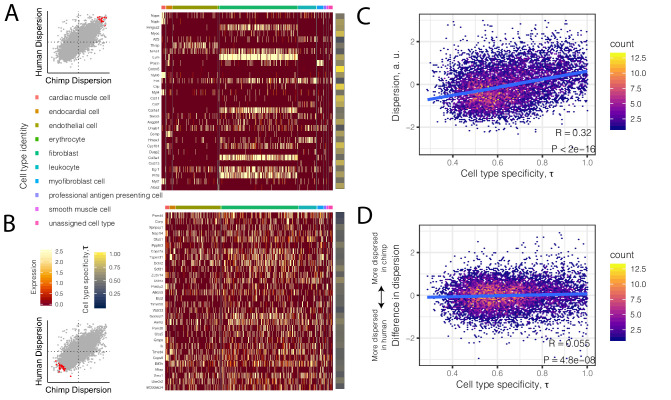
High dispersion genes are expressed in a cell-type-specific manner.(A) The top 30 most dispersed genes (the mean of the dispersion estimates between human and chimpanzee) are shown in a mouse heart single cell RNA-seq dataset (Tabula Muris Consortium et al., 2018). Scatterplot inset on the left shows the dispersion estimate of the 30 genes in chimpanzee and human (red points) compared to all other genes (gray). Each row in the heatmap is a gene. Each column is a single cell, grouped by cell type (colors at top of columns). Normalized expression is colored in the body of the heatmap. The τ statistic, colored on the right of the heatmap, summarizes for each gene how cell-type-specific the gene is, ranging from 0 (equally expressed among all cell types) to 1 (expressed exclusively in a single cell type). (B) The same as (A) but for the bottom 30 most dispersed genes. (C) Across all genes, a hexbin scatterplot shows the correlation between cell-type-specificity (τ) estimated from mouse single-cell RNA-seq data, and dispersion (mean of human and chimpanzee dispersion for each gene) estimated from the bulk RNA-seq data. (D) The difference in dispersion between chimpanzee and human is only weakly correlated with cell-type-specificity. R and p-value for (C) and (D) represent Pearson’s correlation.